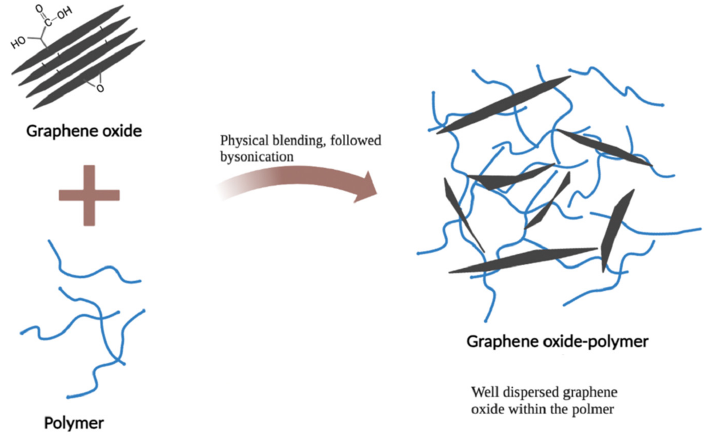
Figure 10. Formation of a well-dispersed graphene oxide–polymer nanocomposite with graphene being embedded in polymeric